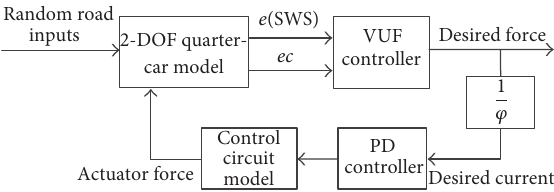
Figure 1: The VUF control schematic of the AERS.